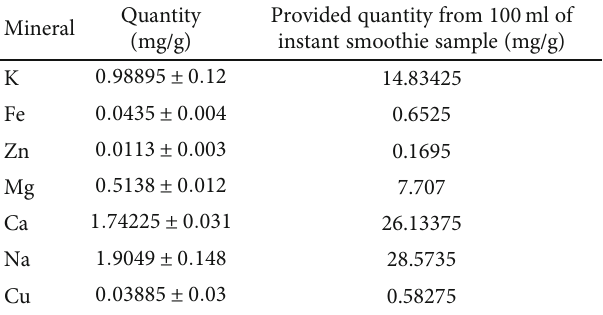
Table 2: Mineral content (K, Fe, Zn, Mg, Ca, Na, and Cu) of the instant green smoothie sample and the provided mineral amount from 100 ml of instant smoothie sample (mg). Results are presented as mean ± standard deviation of two independent